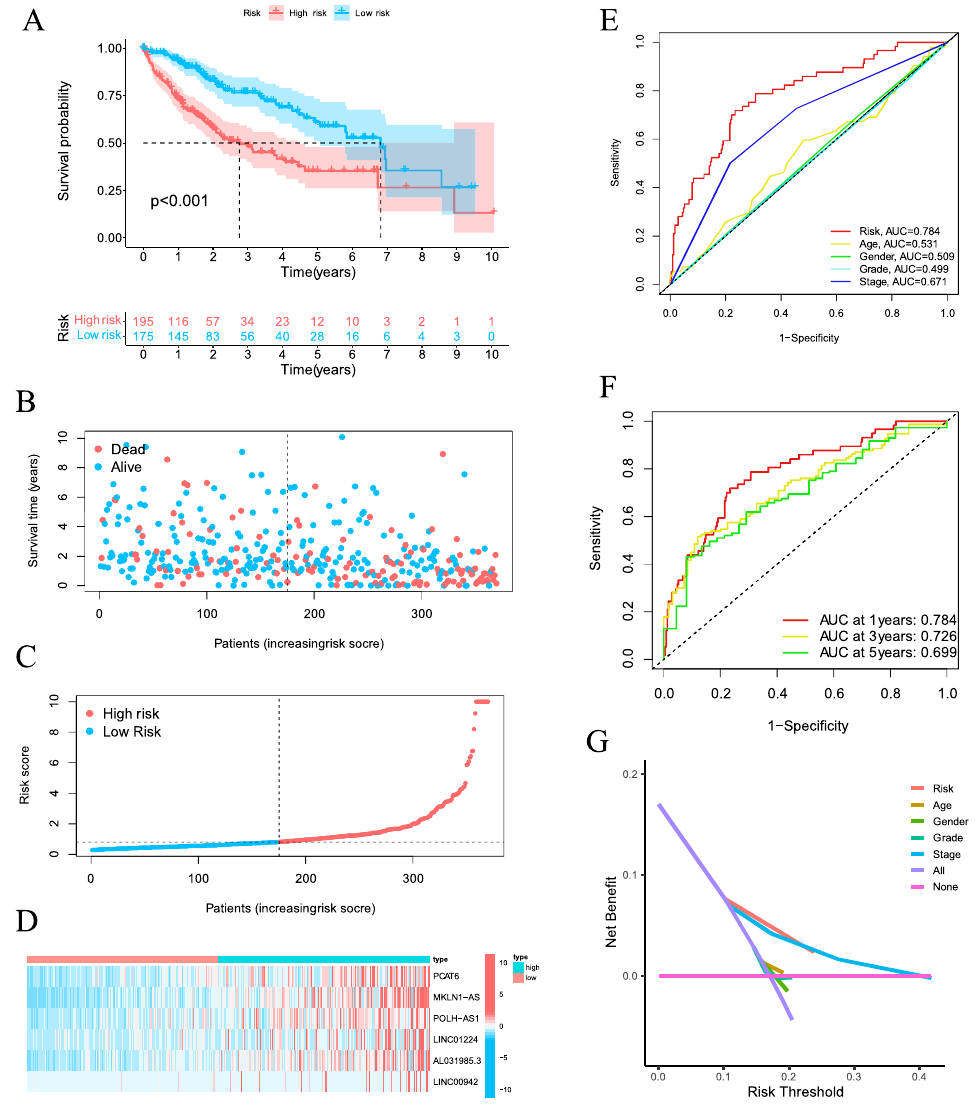
Figure 4. Ferroptosis-related lncRNAs prognostic signature based on TCGA entire set. ( A ) Kaplan–Meier survival curves of the OS of patients were ranked by riskScore for the entire set. ( B ) Distribution of ferroptosis- related lncRNA signature was based riskScore for the entire set. ( C ) Patterns of the survival time and survival status between the high- and low-risk groups for the training set. ( D ) Clustering analysis heatmap shows the display levels of the 6 lncRNA for each patient in the training set. ( E ) The AUC values of the risk factors. ( F ) The AUC for the prediction of 1, 3, 5-year survival rate of LIHC. ( G ) The DCA of the risk